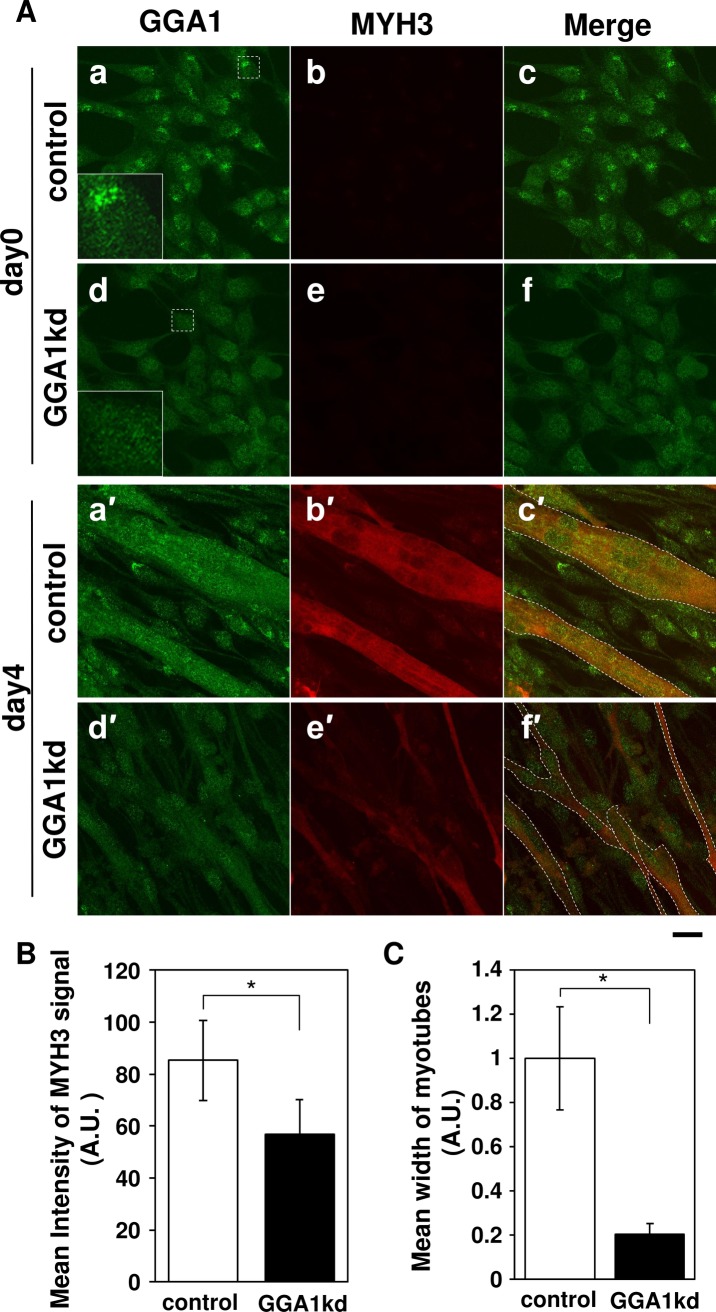
Gga1 knockdown impaired the formation of large myotubes and expression of MYH3.(A) Morphological analysis of Golgi associated, gamma adaptin ear containing, ARF binding protein 1 (GGA1)-depleted myotubes. C2C12 cells transfected with a control short interfering RNA (siRNA) (control: a-c and a′-c′) and Gga1 siRNA (GGA1kd: d-f and d′-f′) were subjected to immunofluorescence microscopy before (day 0) or after differentiation for four days (day 4) using anti-GGA1 (a, d, a′, and d′: green) and anti-myosin heavy chain 3 (MYH3) (b, e, b′, and e′: red) antibodies. The merged images are indicated in the right column. (B) Quantitative analysis of the MYH3 signal in the control and Gga1kd myotubes at day 4. The signal density is plotted. Error bars indicate the SD (n = 8). (C) Quantitative analysis of the average cell width in the control and Gga1kd myotubes at day 4. The value is plotted. Error bars indicate the SD (n = 4). *. P < 0.01 by Welch’s t-test. Scale bar: 10 mm.